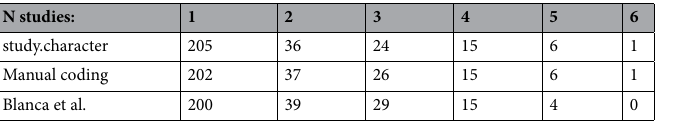
Table 13. Absolute frequencies of extracted number of studies per paper by study.character , the manually coded data and Blanca et al.’s Table 2.